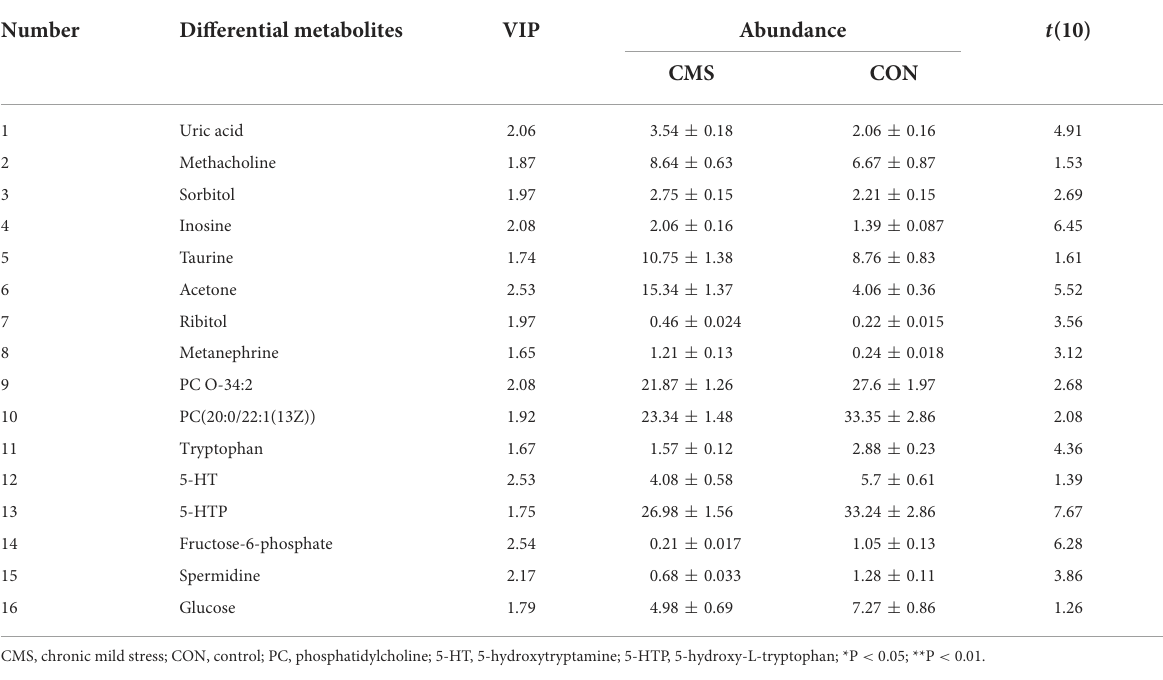
TABLE 1 List of differential metabolites between CMS group and CON group.